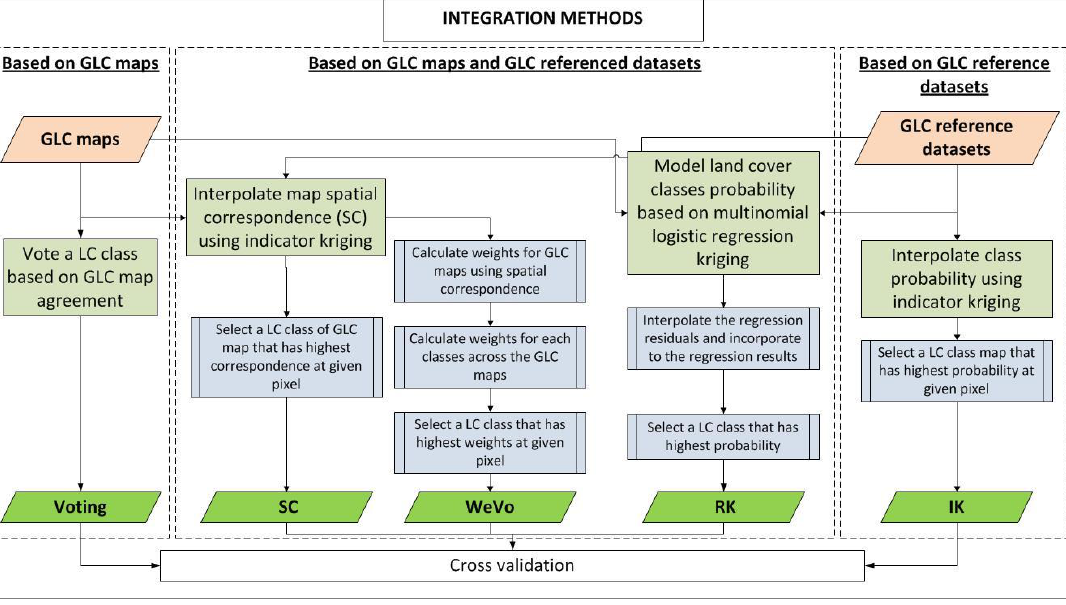
Figure 4. Conceptual diagram of different integration methods.